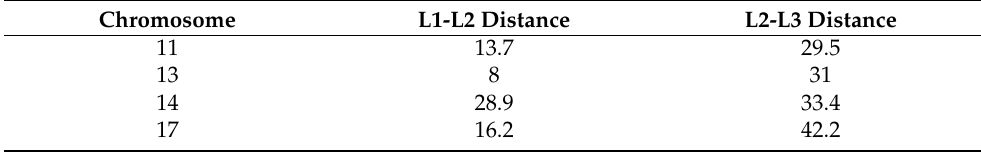
Table 2. Distances between FISH regions computed from CBCR models at 100 kb